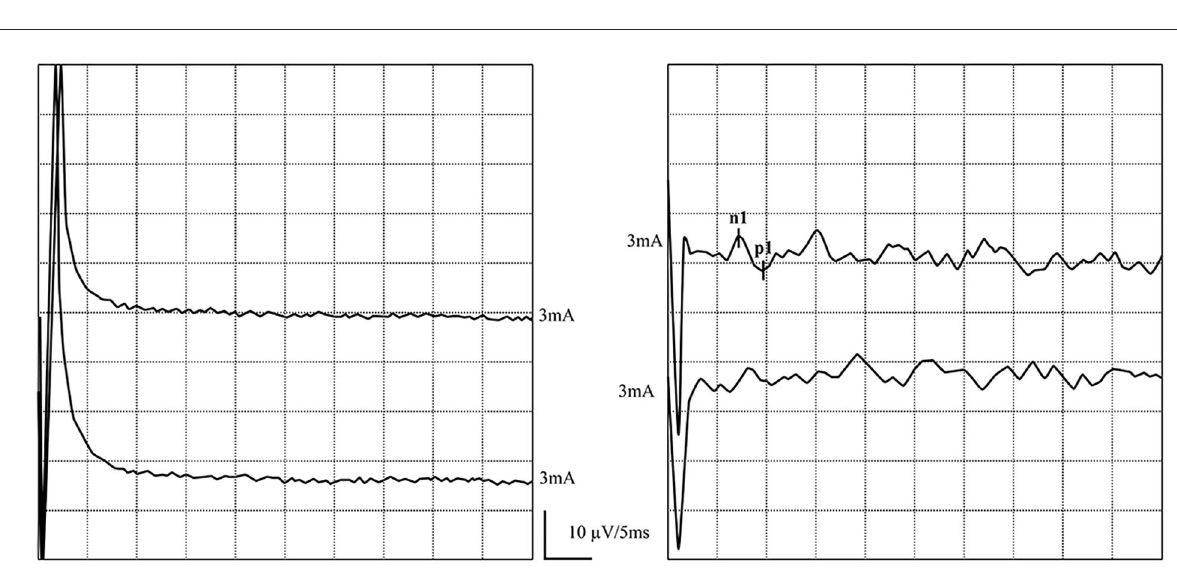
FIGURE7 Normal and abnormal GVS-oVEMP waveforms: Not elicited on the left and elicited on the right side. (left) Abnormal GVS-oVEMP waveforms: Not elicited on the left side. (right) Normal GVS-oVEMP waveforms: Elicited on the right